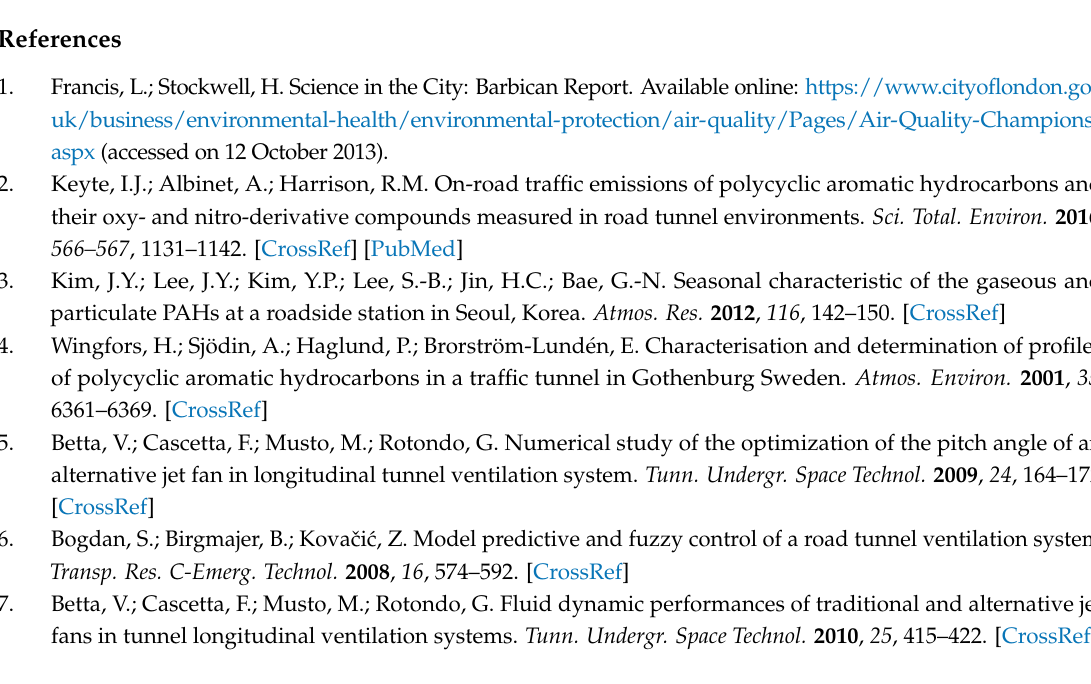
Figure A2. Span-wise velocity and vertical velocity along left pedestrian side in Case_ss [150] and Case_ss [150] (real shape). ( a ) Span-wise velocity; ( b ) vertical velocity.